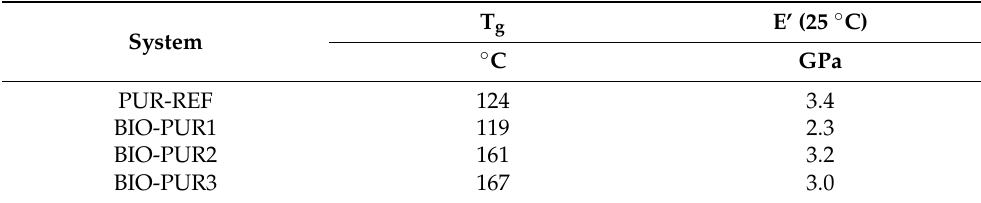
Figure 3. Storage modulus (E’, continuous line) and loss factor (tan δ , dashed line) vs temperature for PUR systems. Table 2. Storage modulus at room temperature and T g values for BIO-PUR/PUR